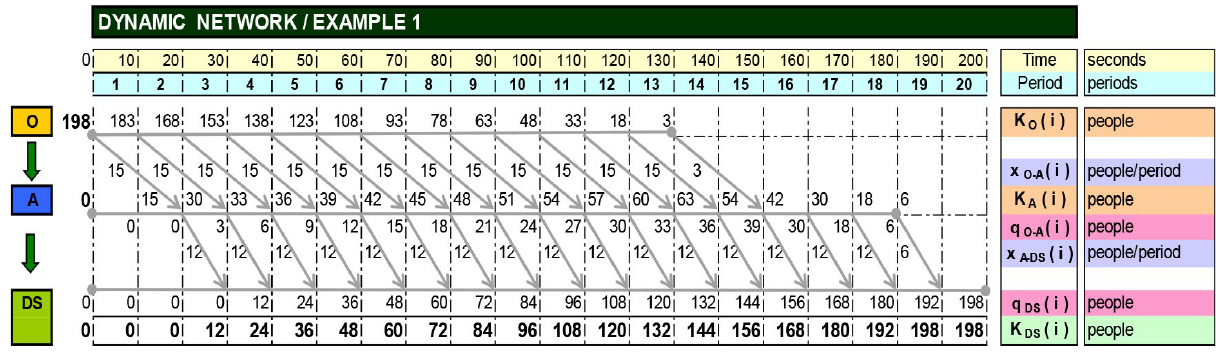
Figure 9. Dynamic network of an evacuation route used as an